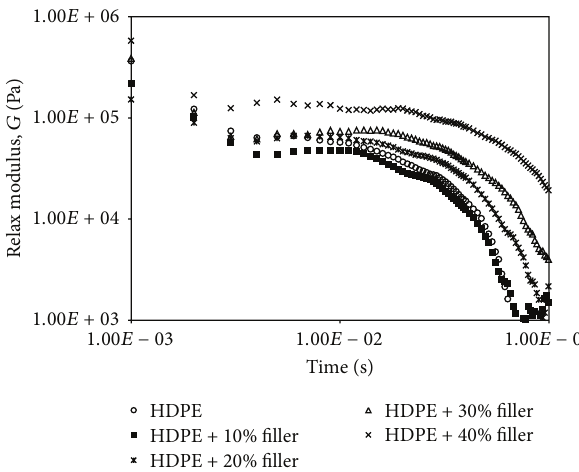
Figure 5: Variation of relaxation modulus with time for neat renewable HDPE and its composites containing different wt% of sponge gourd filler. The experiments were performed at a constant strain of 0.3% in nitrogen atmosphere.